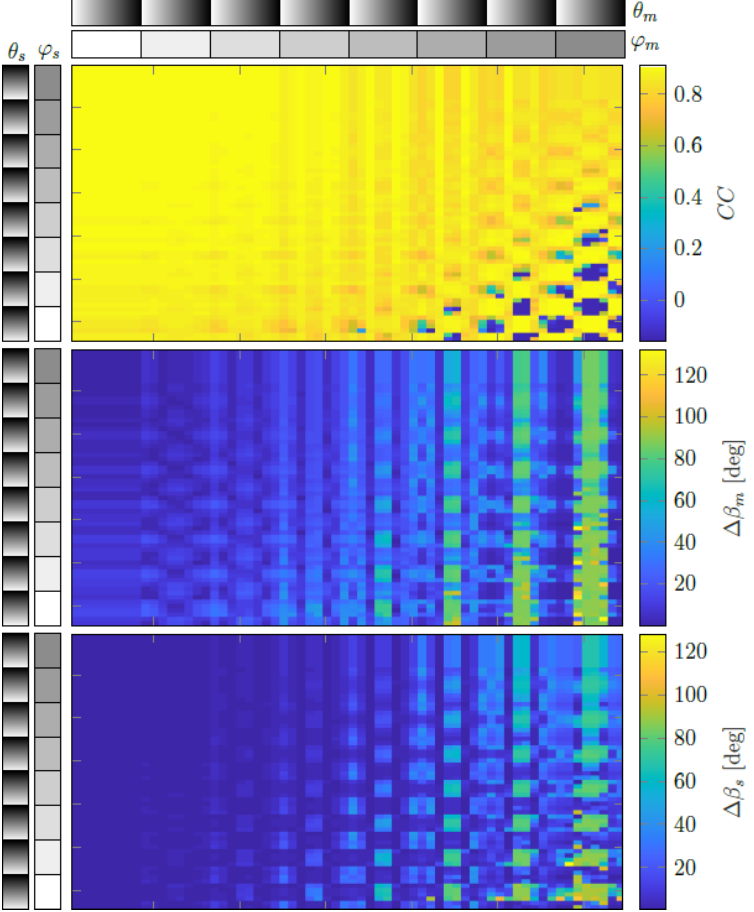
Figure 9. ( Top ): Correlation coefficient of the reconstruction to the ground truth. ( Middle ): Angle error of the magnetic dipole direction. ( Bottom ): Angle error of the sensitive axis direction. All points in the graph are results for a different combination of an initial dipole field direction, indicated by angles θ m (polar) and ϕ m (elevation), and sensitive axis directions, indicated by angles θ s (polar) and ϕ s (elevation). The grey colorbars denote the angle (white is 0 ◦ and black is 360 ◦